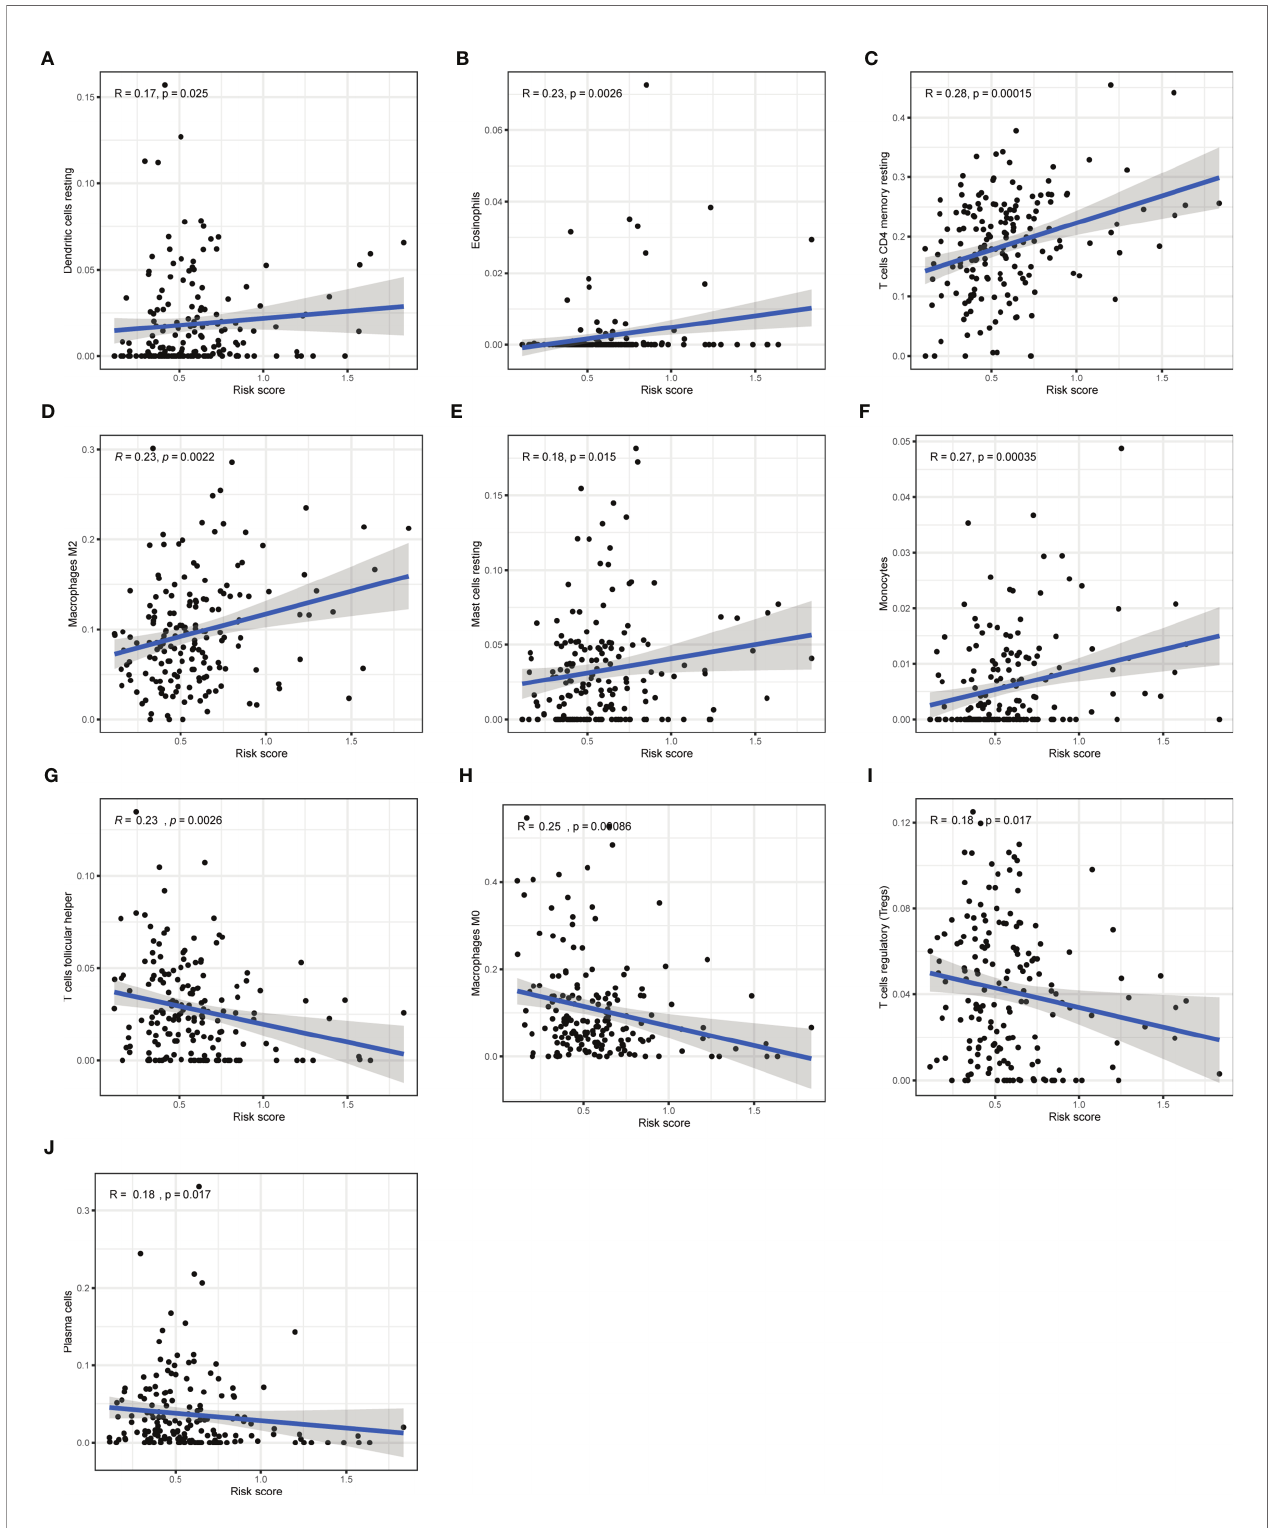
FIGURE 9 | Correlation of subgroup with immune in fi ltration level in STAD. (A – F) The high-risk group has signi fi cant positive correlations with resting DC, eosinophils, memory resting CD4 T cells, M2 macrophages, resting mast cells, and monocytes. (G – J) The high-risk group has signi fi cant negative correlations with M0 macrophages, plasma cells, follicular helper T cells, and regulatory T